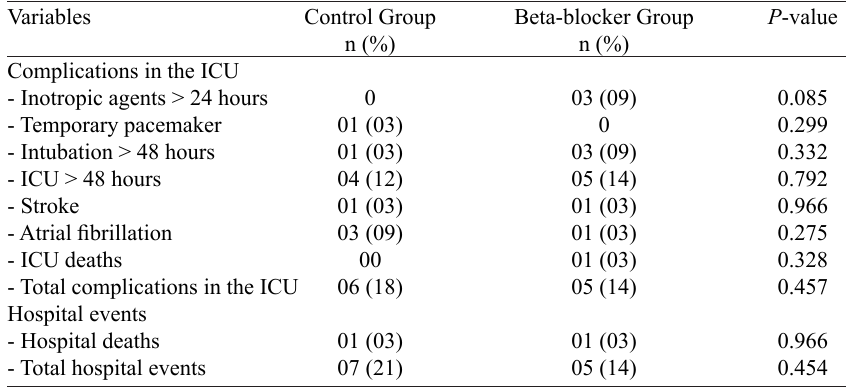
Table 6. Comparison of complications in the intensive care unit and hospital events between the control and beta-blocker groups.